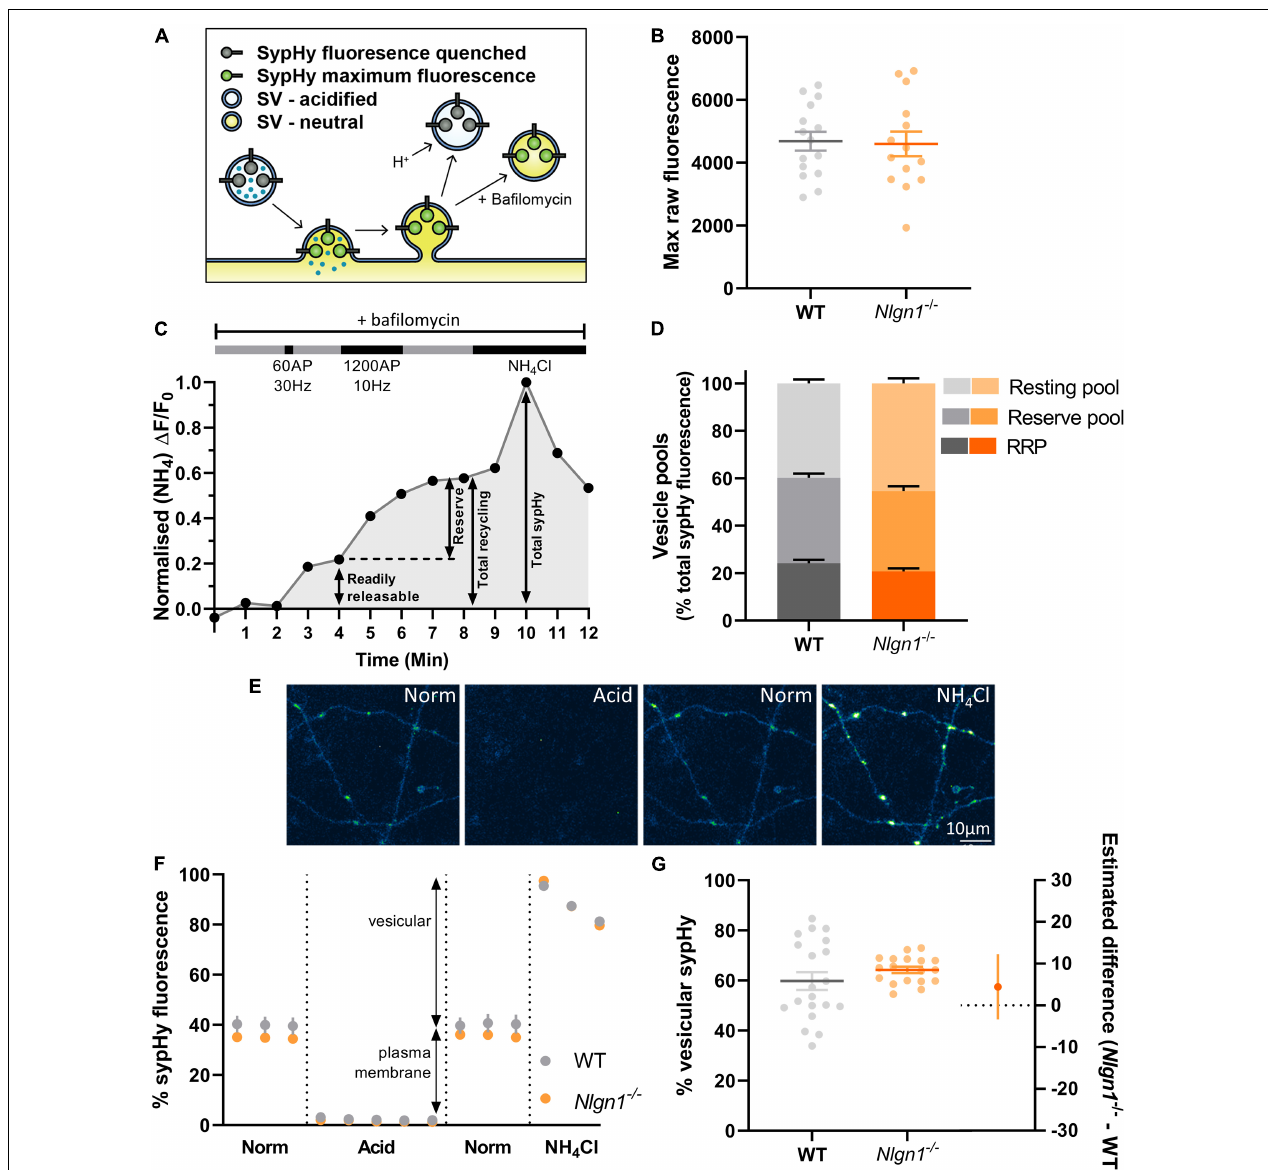
FIGURE 1 | Lack of Nlgn1 has does not impact the size of synaptic vesicle pools. Nlgn1 − / − and WT cultured neurons were transfected with sypHy. (A) sypHy is a genetically encoded, pH-sensitive fluorescence reporter of synaptic vesicle (SV) dynamics. (B) Scatter plot of total sypHy fluorescence in Nlgn1 − / − and WT neurons, as assessed by perfusion with NH 4 Cl; mean ± SEM indicated. N = 14–15 individual fields of view from independent coverslips, unpaired t -test, p = 0.8601. (C) Stimulation protocol for assessing specific synaptic vesicle pools. Neurons were stimulated with 60 action potentials (AP) at 30 Hz to trigger fusion of the readily releasable pool (RRP), followed by 1200 AP at 10 Hz to mobilise the reserve pool of vesicles (together composing the total recycling pool), in the presence of bafilomycin to inhibit vesicle reacidification. The remaining vesicles, which do not undergo fusion, comprise the resting pool. Fluorescence change was monitored over time, and neurons were then perfused with NH 4 Cl to reveal total sypHy fluorescence; fluorescence change from baseline was normalised to the total sypHy fluorescence. (D) Synaptic vesicle pool sizes in Nlgn1 − / − and WT synapses. Size of distinct vesicle pools (readily releasable, reserve, and resting as a proportion of total sypHy fluorescence) averaged over individual coverslips are shown in stacked column graphs. N = 10–13 individual fields of view from independent coverslips, values represent mean ± SEM. Two-way ANOVA with Sidak’s multiple comparison test; RRP p = 0.4256, reserve pool p = 0.7539; resting pool p = 0.0744. (E) Representative images of neurons transfected with sypHy following perfusion with different imaging buffers. Neurons were perfused with normal saline (norm) imaging buffer, followed by acidic buffer (pH 5.5; acid) which quenches cell surface fluorescence (i.e., sypHy localised to plasma membrane) to reveal background autofluorescence. Neurons were washed with normal saline imaging buffer before being perfused with NH 4 Cl buffer to reveal total sypHy fluorescence. Scale bar indicates 10 µ m. Images are false coloured to show relative sypHy fluorescence, with brighter, warmer colours indicating increased fluorescence intensity. (F) Fluorescence trace for quantifying the partitioning of sypHy to distinct membranous compartments in Nlgn1 − / − and WT synapses. Values are mean ± SEM. (G) Scatter plots shows % vesicular sypHy {[(total – background) – (surface – background)]/(total – background) × 100} averaged over individual coverslips. N = 18–20 individual fields of view from independent coverslips, mean ± SEM indicated. Forest plot shows estimated difference between genotype with 95% CI, Welch’s t -test, p = 0.2674.